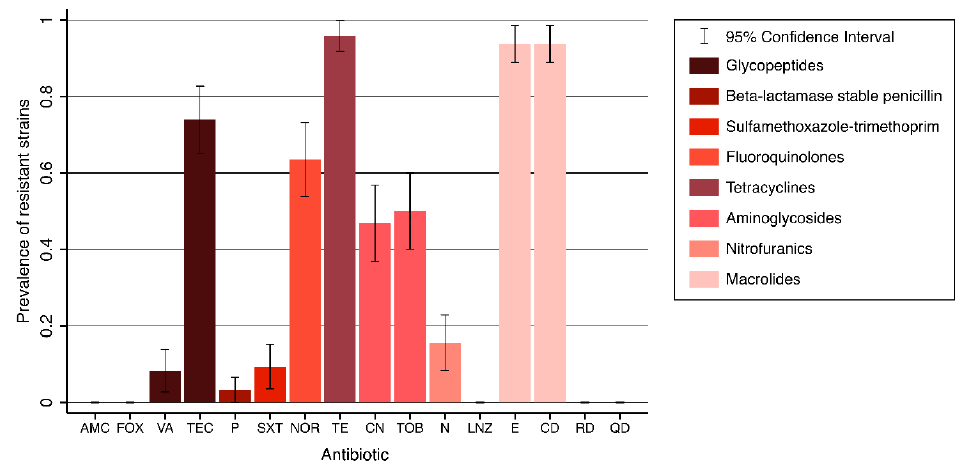
Figure 1. Prevalence of resistance against each antibiotic, with error bars showing 95% confidence intervals (AMC: Amoxicillin-Clavulanate; FOX: Cefoxitin; VA: Vancomycin; TEC: Teicoplanin; P: PenicillinG;SXT:Sulfamethoxazole-Trimethoprim; NOR:Norfloxacin; TE:Tetracycline; CN:Gentamicin; TOB: Tobramycin; N: Nitrofurantoin; LNZ: Linezolid; E: Erythromycin; CD: Clindamycin; RD: Rifampin; QD: